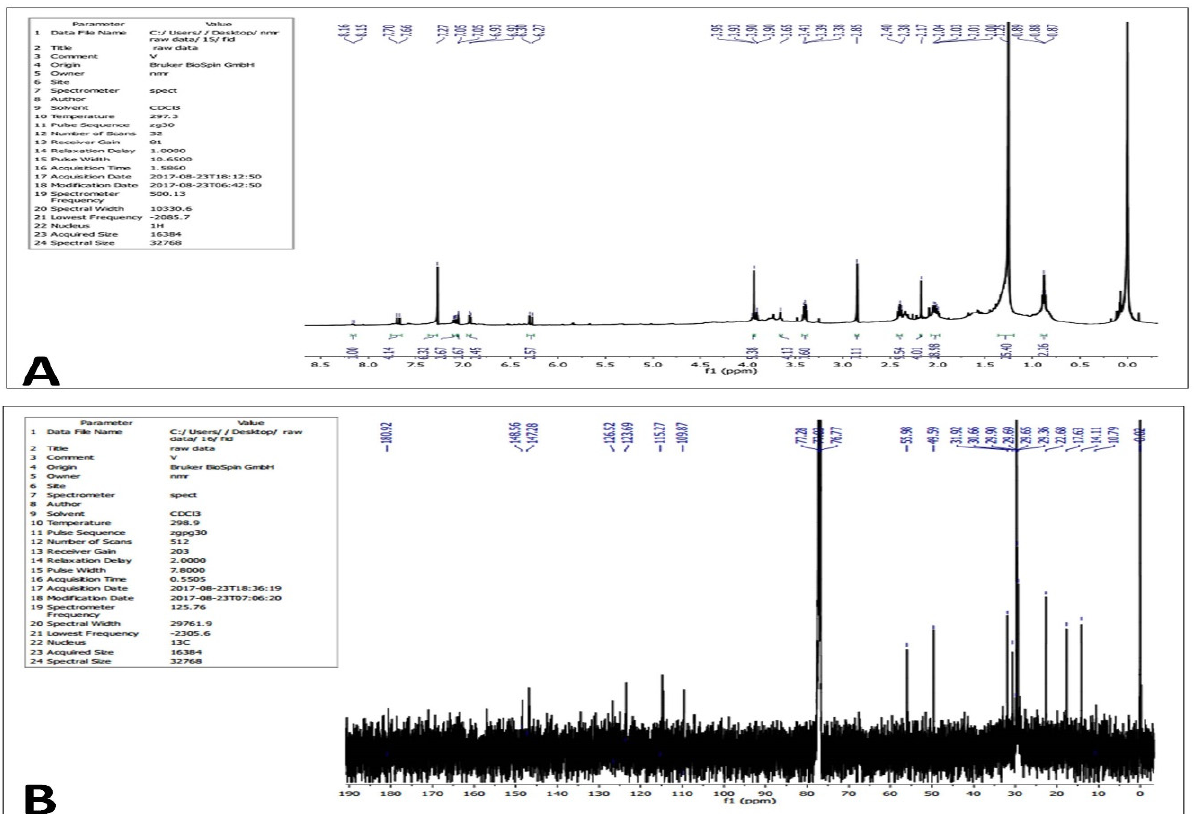
Figure 8. 1 HNMR ( A ) and 13 CNMR ( B ) spectrum of the purified compound from the extracts of Leucas indica flowers.